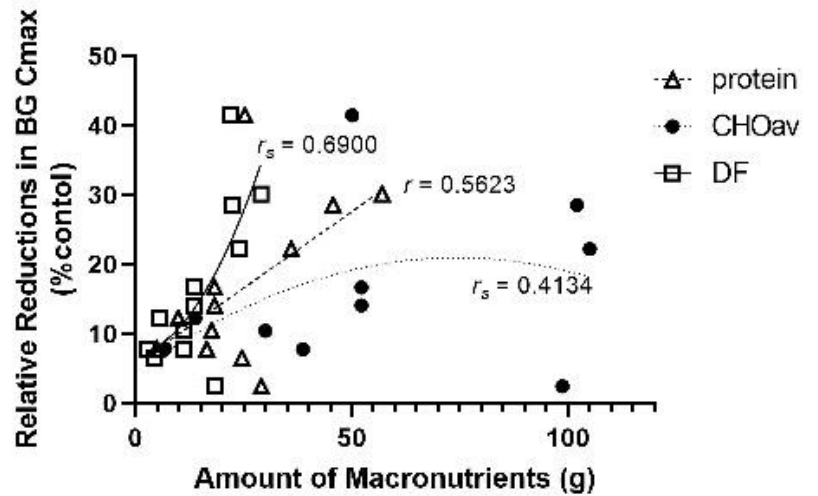
Figure 11. Relative reductions (%) of maximum BG concentration (Cmax, mmol/L) according to the amount of macronutrients or dietary fibre (g) in the lentil treatment group with respect to the control group. Available carbohydrates (CHOav; r s = 0.4134; n = 10; ns ) and dietary fibre (DF; r s = 0.6900, n = 12; p < 0.05) were best described with quadratic modeling, and protein ( r = 0.5623; n = 12; ns ) was best fit with a linear model.